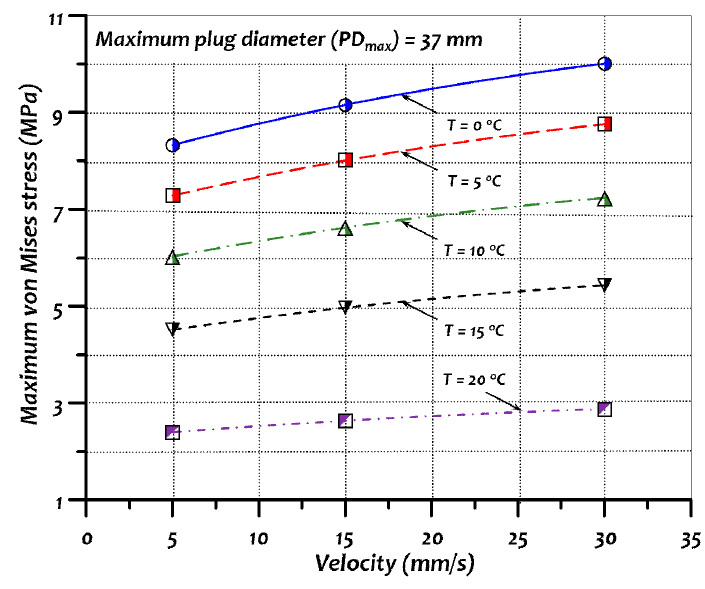
Figure 17. E ff ect of velocity on maximum von Mises stress at PD max = 37 mm. Figure 17. Effect of velocity on maximum von Mises stress at PD max = 37 mm. Figure 17. Effect of velocity on maximum von Mises stress at PD max = 37 mm.